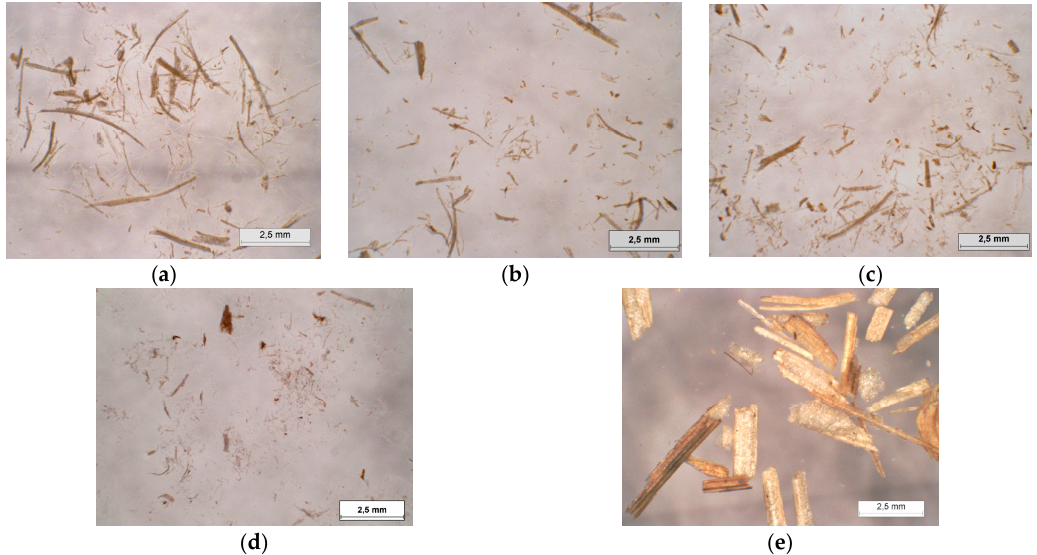
Table 2. Density and morphological characteristics of refined coriander straw. L/S, liquid/solid. Refining Process